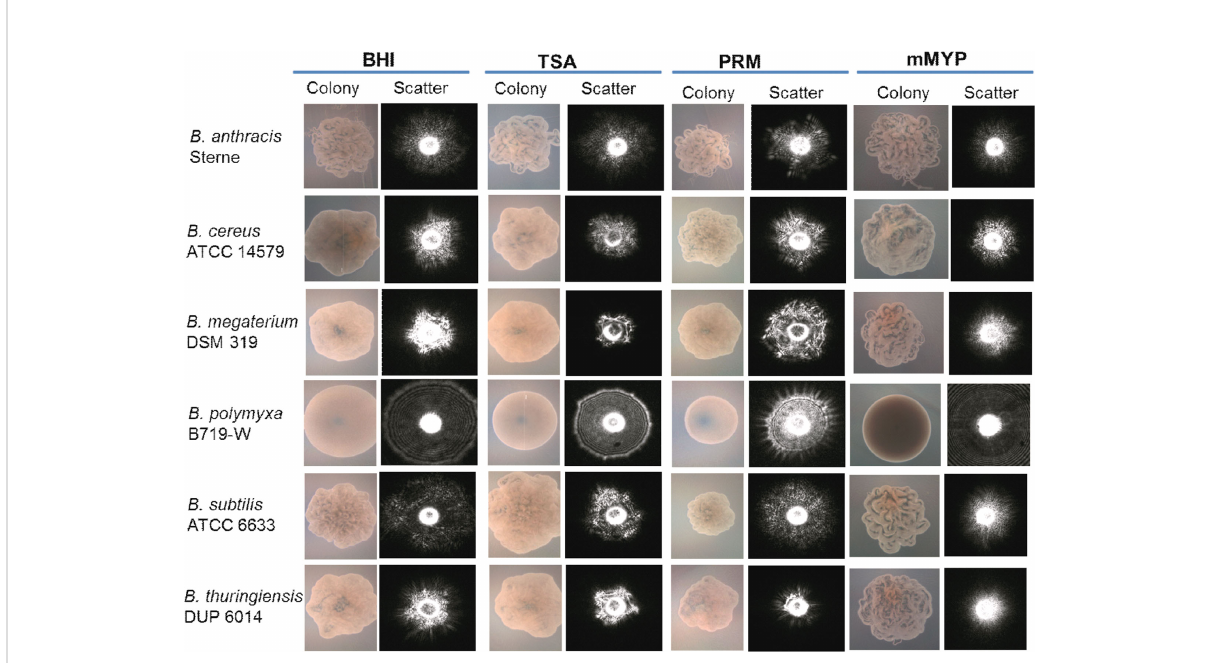
FIGURE 4 Microscopic images of colonies and corresponding scatter images of colonies of Bacillus species grown on BHI, brain heart infusion; TSA, tryptic soy agar; PRM, phenol red mannitol; and mMYP, modi fi ed mannitol egg yolk polymyxin without egg yolk. Source (Singh et al.,